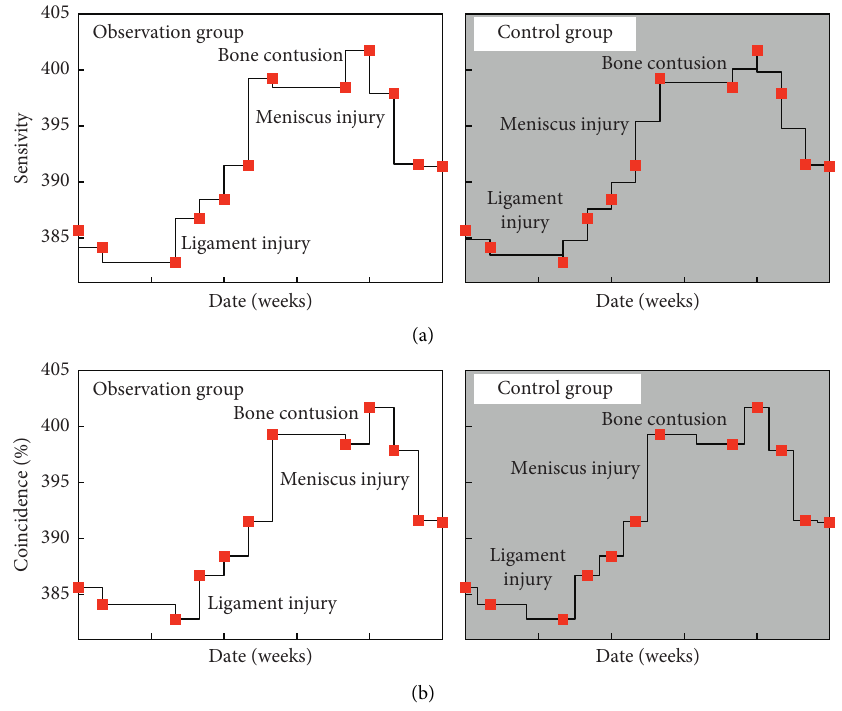
Figure 10: Sensitivity for different reconstruction methods at different recovery stages.